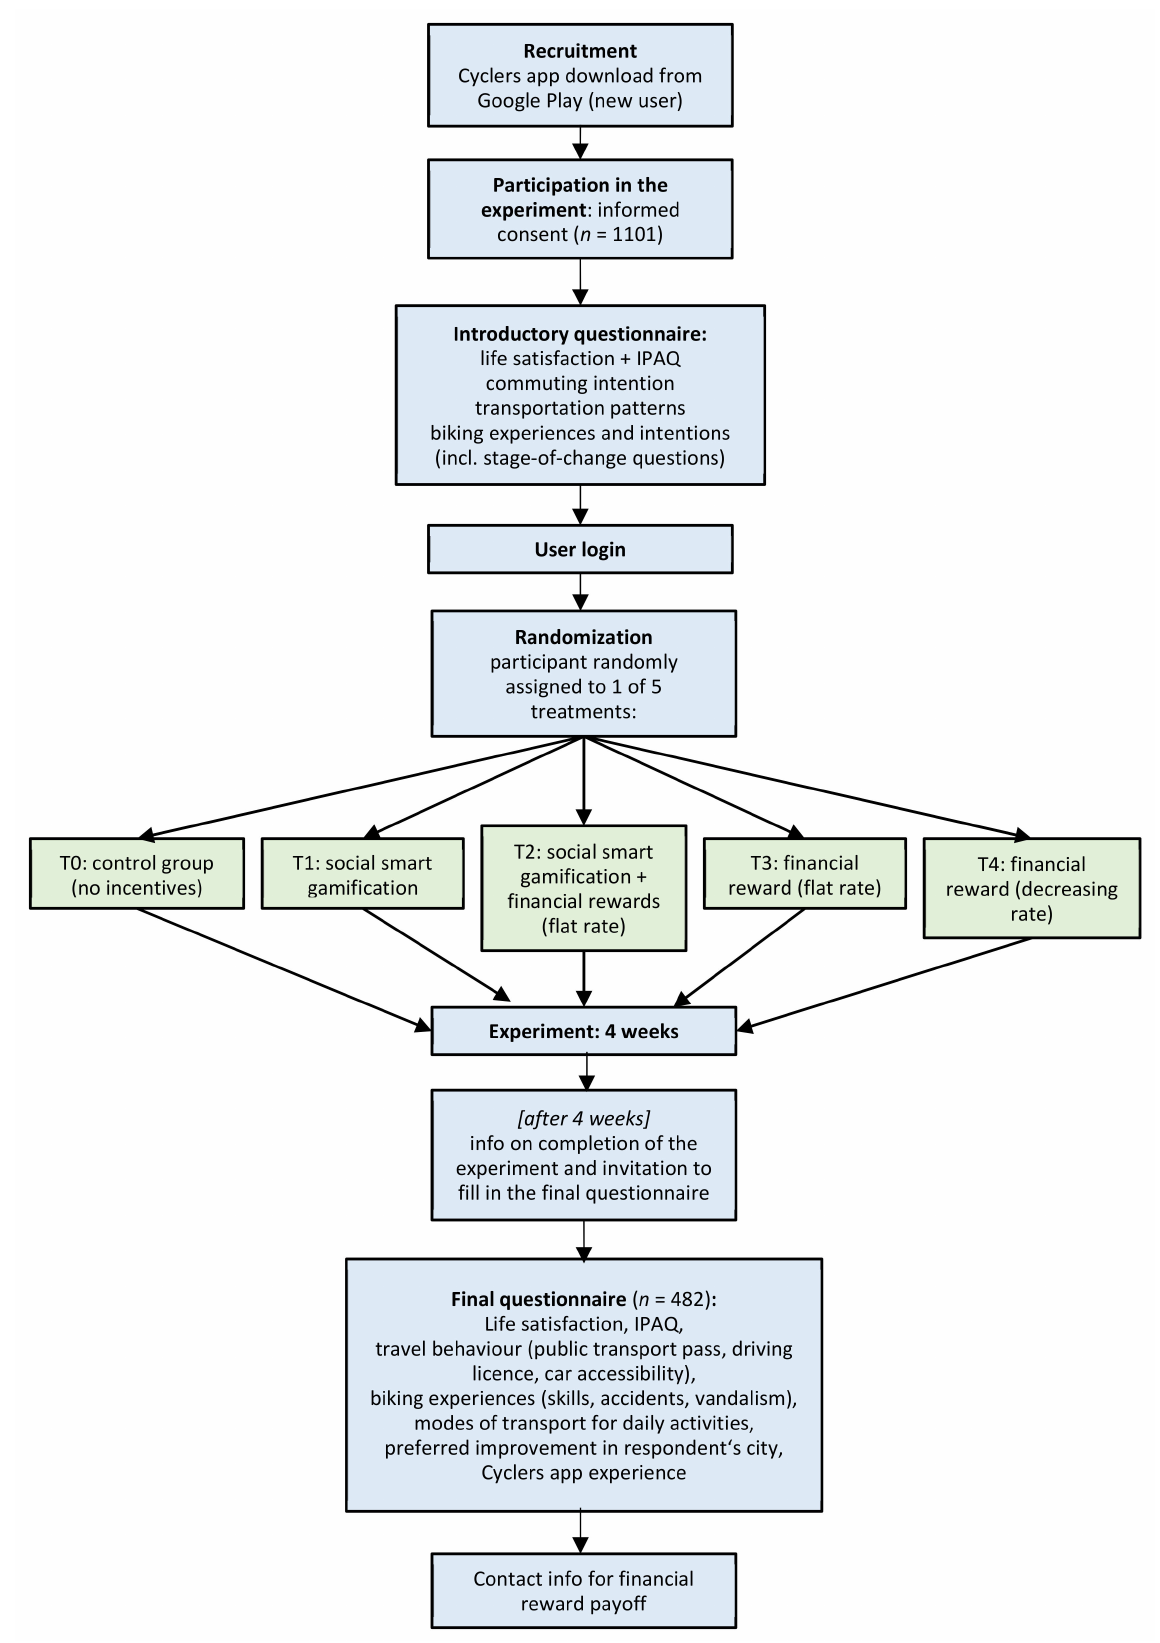
Figure 1. Flow diagram of the